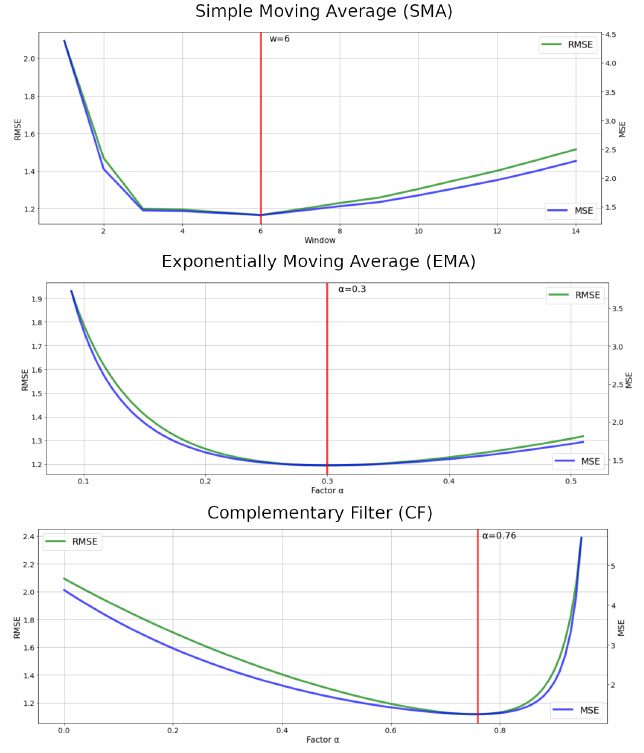
Figure 11. Optimal points of the adjustable filters